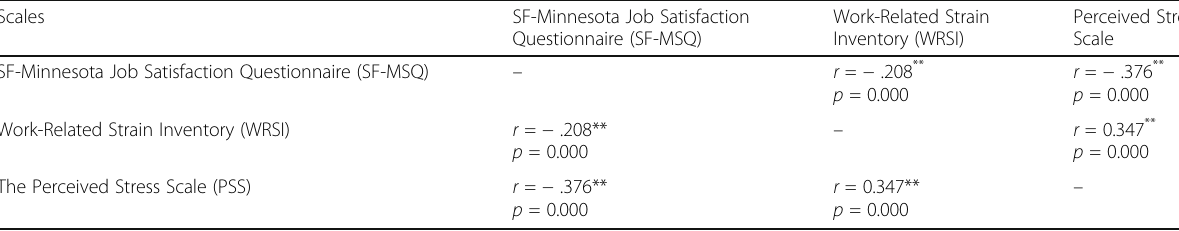
Table 8 Correlation of the scores of SF-MSQ, WRSI, and PSS ( N =